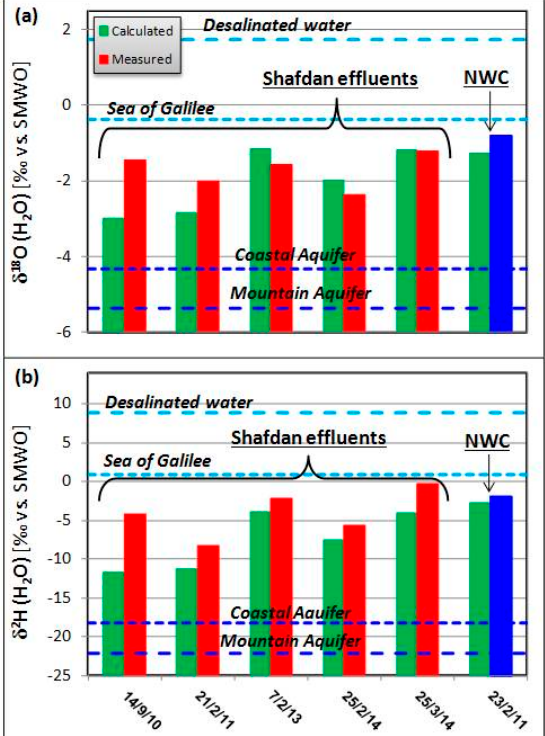
Figure 4. Fresh water mixing assessment in the NWC and in the Shafdan for: δ 18 O ( a ); and δ 2 H ( b ). The sampling point for the NWC is located at the entrance to Tel Aviv. Samples for the Shafdan effluents were taken at the outlet station (PS ‐ 6) that pumps the effluents to the recharge ponds.